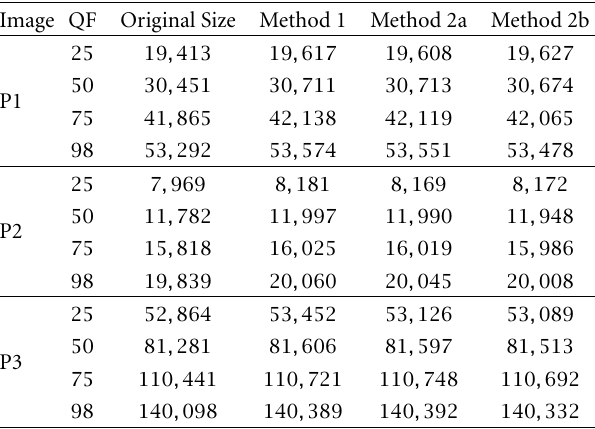
Table 4: File sizes in bytes before and after embedding 128bits. All experiments were done with the DCT coefficient ( 6 , 6 ) .